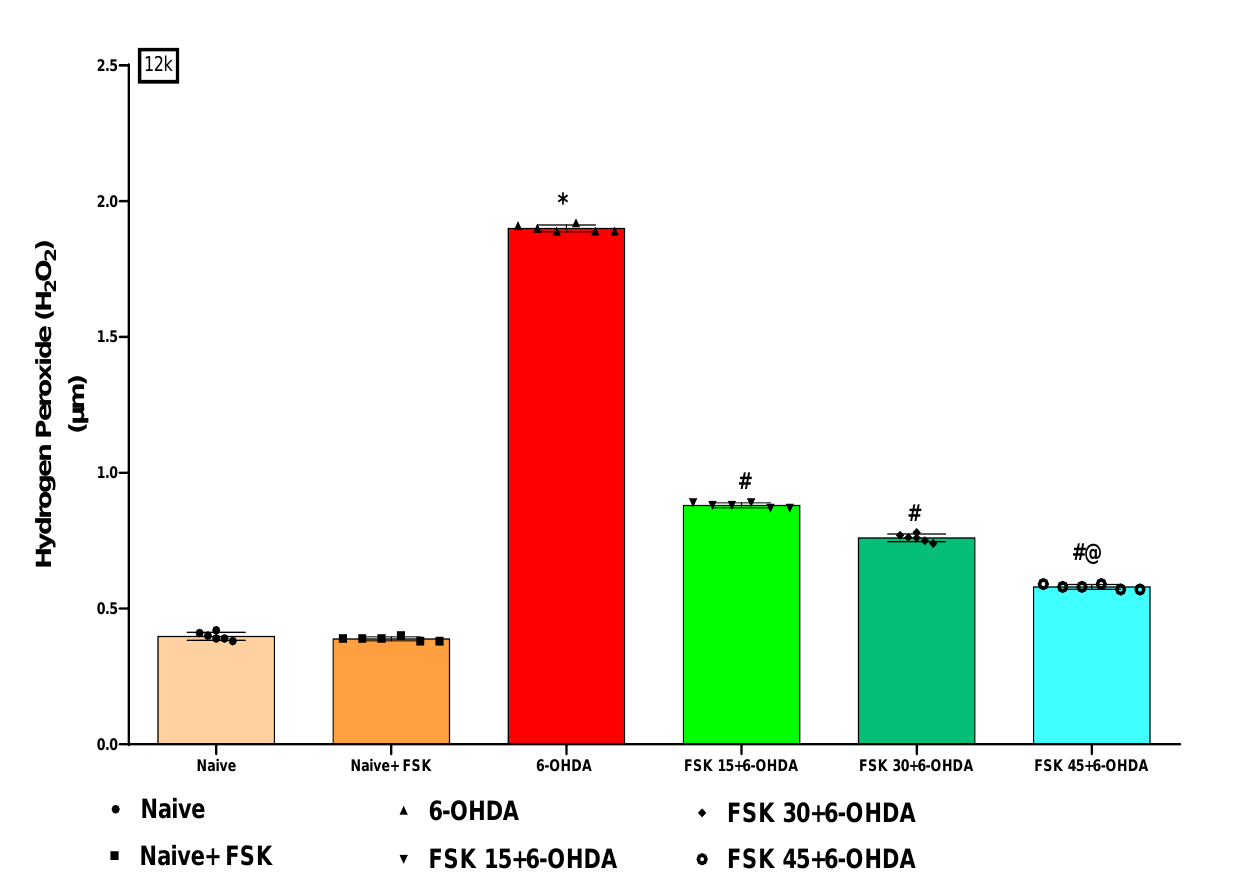
Figure 12. ( a – k ) FSK restored anti-oxidant levels in the experimental model of PD. Data provided as mean ± SD (n = 6 ) followed by ANOVA (one-way) with post-hoc Tukey’s test. * 6-OHDA (p < 0.01 ) compared with naive and naive + FSK; # FSK15, FSK30, FSK45 (p < 0.01 ) compared with 6-OHDA; #@ FSK45 (p < 0.01 ) compared with FSK30, FSK15 .